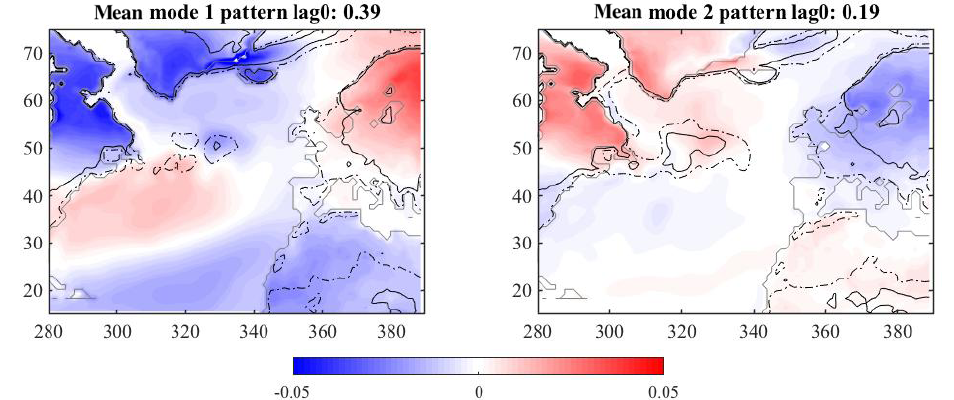
Figure 9. Same as Fig. 6, except for representing the covariance between the North Atlantic 25m ocean temperatures and surface land temperatures at zero lag.